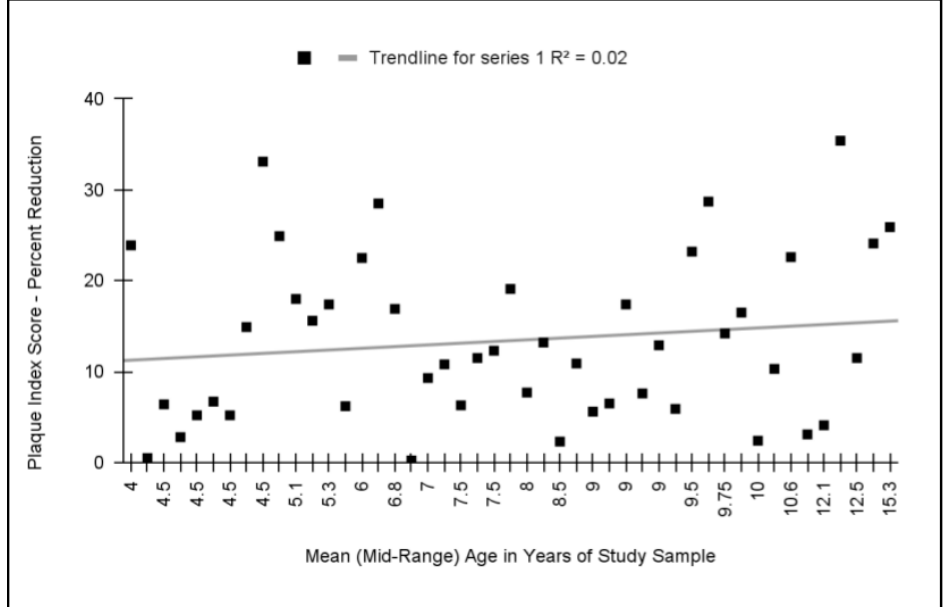
Figure 4. Meta analysis of relative effect (percent reduction in plaque index) plotted against average or mid-range age of study participants. No significant association was found between these variables with a coefficient of determination, R 2 = 0.02. Studies with the average age of participants under six and over six years of age exhibited similar reductions in plaque index with electric toothbrushes (13.5% and 13.3%, respectively), p = 0.899. To evaluate the potential effects on the study outcomes related to the length of study (endpoint measures), these data were graphed and analyzed (Figure 5). This analysis revealed that no significant relationship exists between the length of the study and the relative effect (R 2 = 0.003). More specifically, the average relative effect (plaque index reduction) among the 0 day trials (14.2%) was not significantly different from the average of trials lasting one to two weeks (13.8%), p = 0.711, or trials lasting 30 days or longer (14.1%), p = 0.92.